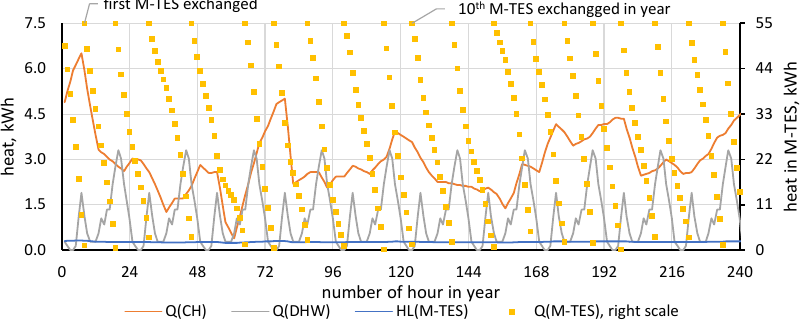
Figure 6. Heat demand and heat losses and heat accumulated in mobile thermal storage system (M-TES) for each hour in the 1–240-h period of the year (January).